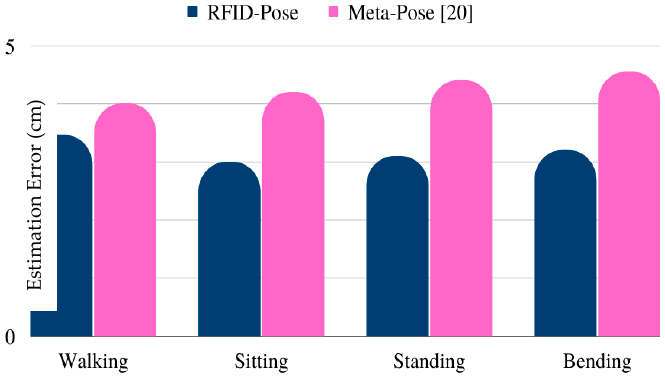
Figure 24. Error estimation comparison for different body poses positions. Table 5. Performance comparison with mean estimation error.